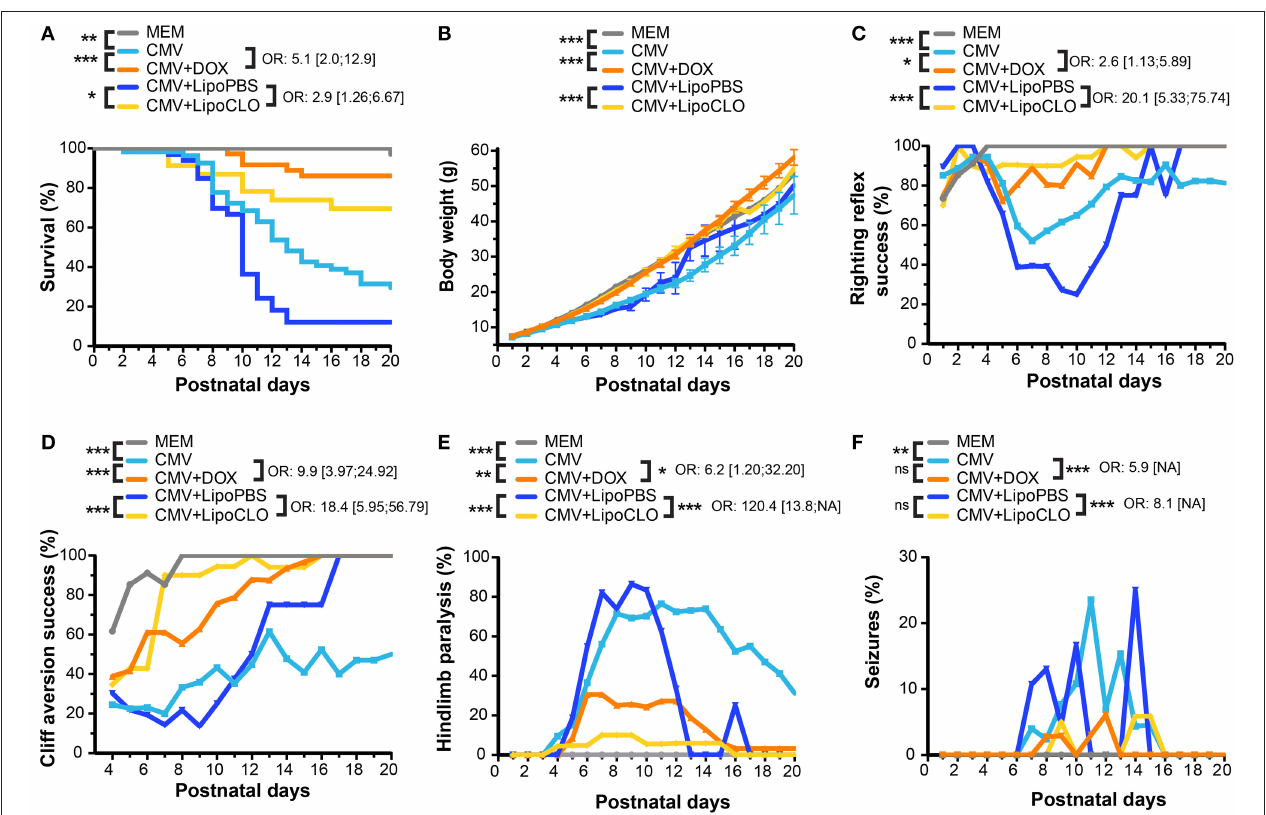
FIGURE 1 | CMV infection of the embryonic rat brain causes decreased survival and neurodevelopmental defects that can be prevented in utero by microglia-targeted drug-based strategies. Phenotypic investigations (see Figure 2 ) in the three first postnatal weeks in pups previously subjected to the following procedures during pregnancy: vehicle intraventricularly (icv) (MEM; n = 34, four litters); CMV icv, pregnant rat fed with doxycycline (DOX) during pregnancy (CMV + DOX; n = 36, four litters); CMV icv, untreated pregnant rat (CMV; n = 54, six litters); CMV with clodronate liposomes icv (CMV + LipoCLO; n = 23, two litters); CMV with PBS liposomes icv (CMV + LipoPBS; n = 33, four litters). Sex ratio did not differ between the five groups at birth ( p = 0.15, Chi-square test). (A) Kaplan-Meier survival curves indicated significant decreased survival in the CMV vs. MEM group, and significant rescues in the CMV + DOX and CMV + LipoCLO groups vs. their untreated counterparts (CMV and CMV + LipoPBS, respectively). (B) Cumulative body weight decreased significantly in the CMV vs. MEM group. Significant improvements were seen in the CMV + DOX and CMV + LipoCLO groups vs. their untreated counterparts (CMV and CMV + LipoPBS, respectively). (C,D) The proportion of animals succeeding to the righting reflex (C) or the cliff aversion reflex (D) sensorimotor tests decreased significantly in the CMV vs. MEM group, and significantly improved in the CMV + DOX vs. CMV group, and in the CMV + LipoCLO vs. CMV + LipoPBS group. (E,F) Hindlimb paralysis (E) and generalized tonic-clonic epileptic seizures (GTCS) (F) occurred significantly more frequently in the CMV vs. MEM group. This improved significantly in the CMV + DOX vs. untreated CMV group and in the CMV + LipoCLO vs. untreated CMV + LipoPBS group. Note that because the most severely affected pups were at higher risk to death, a misleading effect of apparent improvement with time could be perceived from curve shapes even for untreated conditions. Left sides of the cohorts legend: univariate Cox analysis (A) , mixed model for repeated data (B–D) , or Chi2 test with Bonferroni correction (E,F) . Right sides of the cohorts legend: odds ratio (OR) ± confidence intervals correspond to the risks in the untreated